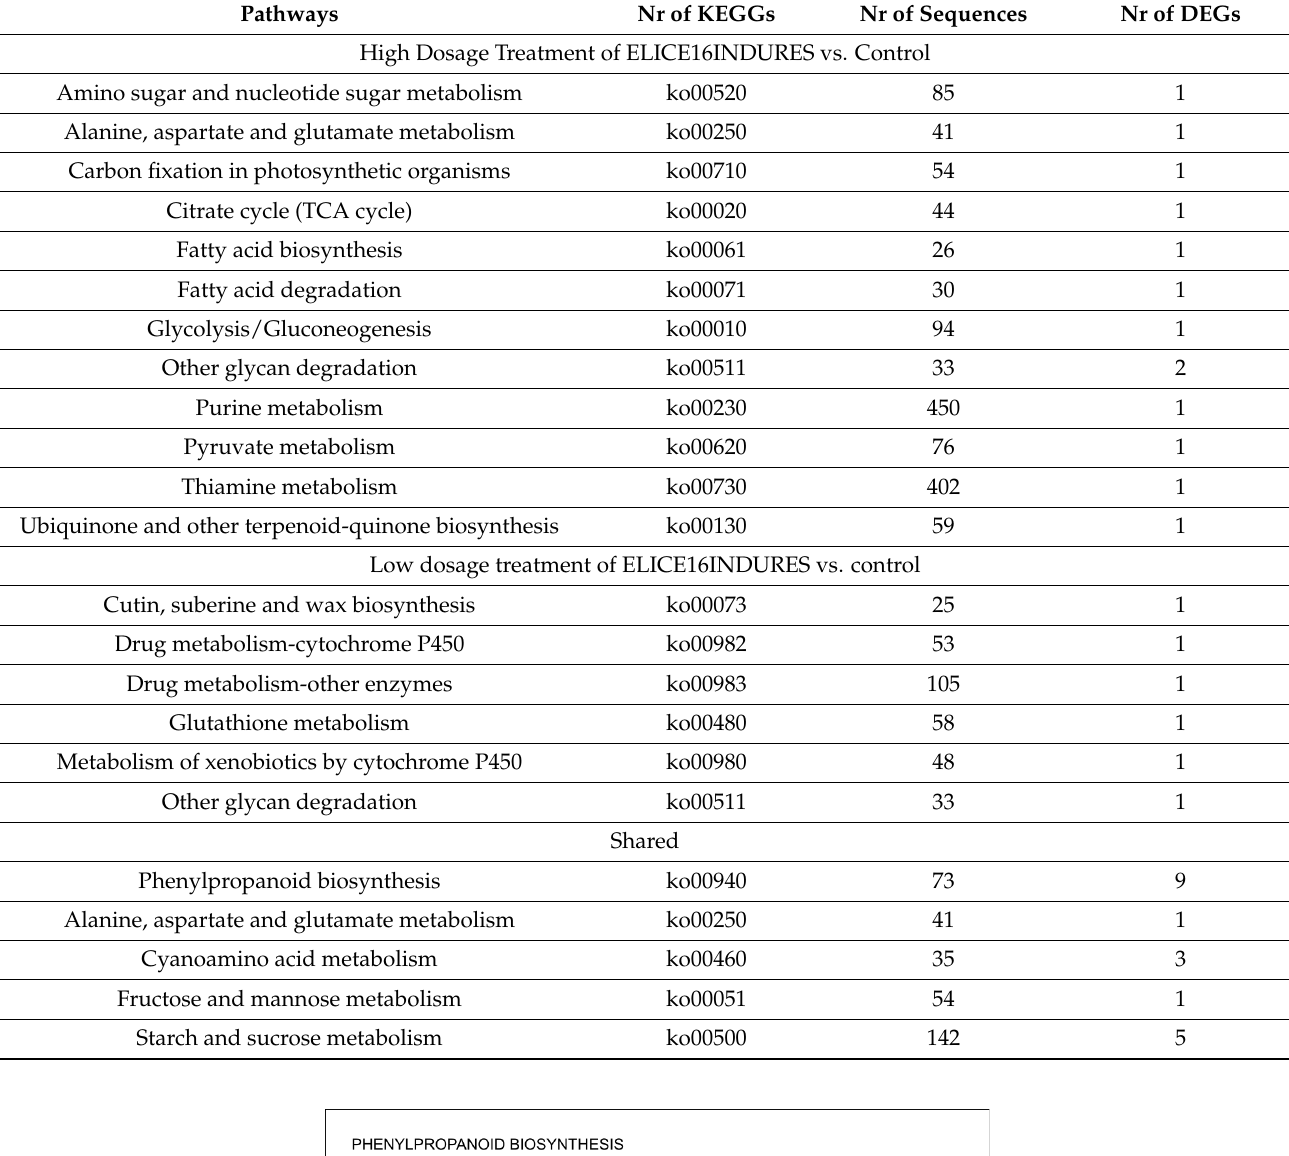
Table 3. KEGG pathways of mapped genes with differential expression in pairwise analysis. Pathways